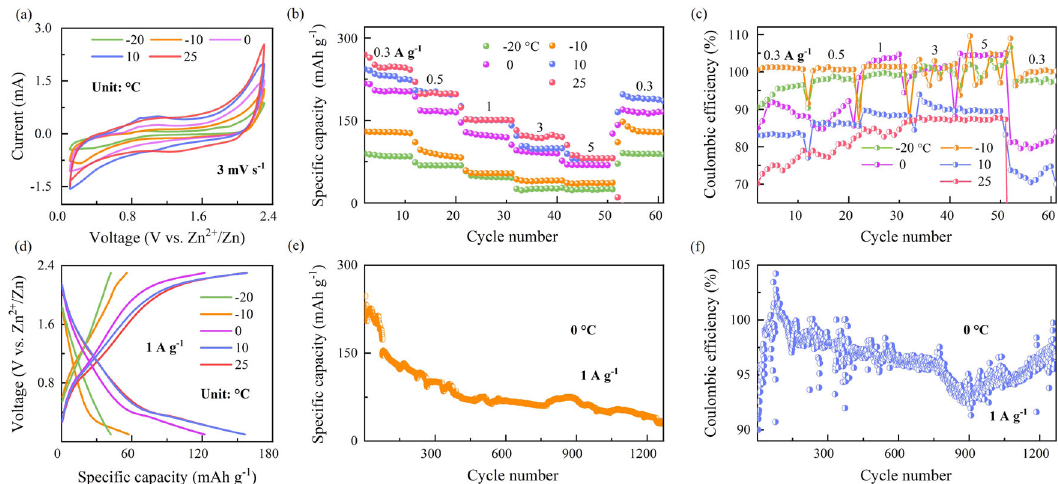
Fig. 2 Electrochemical performance of the rechargeable quasi-solid Zn||P-Bi 2 Se 3 cells over the temperature range − 20 to 25 °C. a CVs for quasi-solid Zn||P-Bi 2 Se 3 cells at different temperatures. b Rate capability and corresponding CE ( c ) and GCD pro fi les ( d ) of the quasi-solid AZIB at different temperatures. e Long-cycle performance and corresponding CE ( f ) at 0